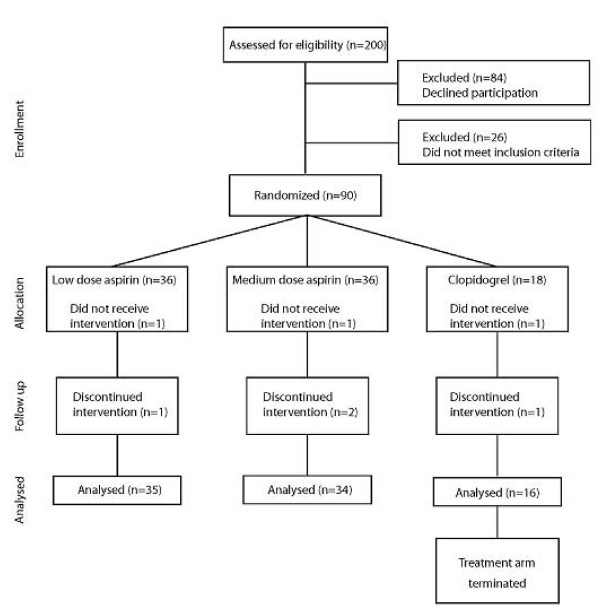
Trial flow diagram. Footnote: numbers that were analyzed were more than expected, taking into account patients who discontinued or did not receive allocated medication owing to intention-to-treat analysis.